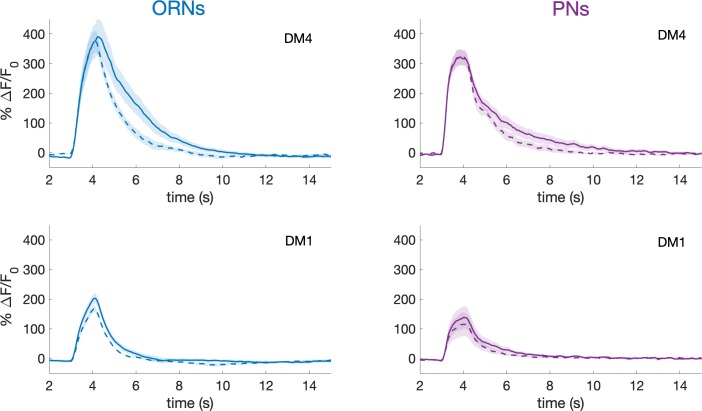
PNs activity recovers from slow adaption within a minute.In this experiment, a single pulse of methyl acetate was delivered one minute before (continuous line) and one minute after (dotted line) the 2 min long pseudorandom stimulus. The response amplitudes in ORNs and PNs innervating glomeruli DM1 and DM4 shows no significant differences. Shaded area represents SEM, n = 6. This demonstrates that the slow adaptation observed here is a different phenomenon from the previously described habituation (Das et al., 2011).